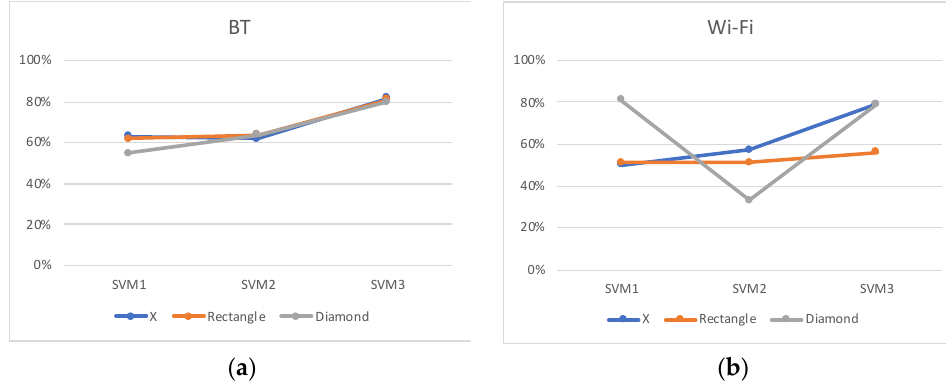
Figure 15. Accuracy of LIP comparison on different topologies: ( a ) accuracy of three SVMs on Bluetooth; ( b ) accuracy of three SVMs on Wi-Fi.